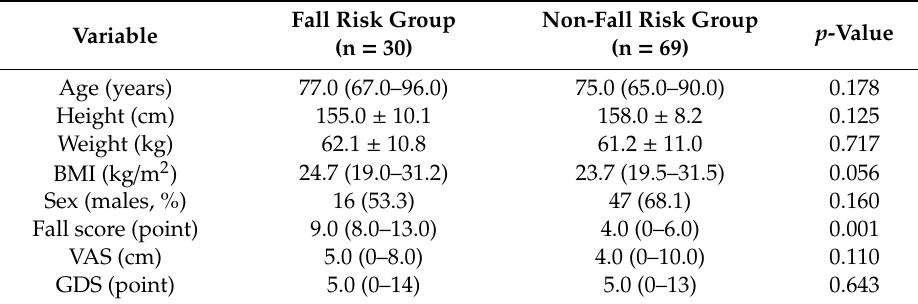
Table 1. Participant characteristics